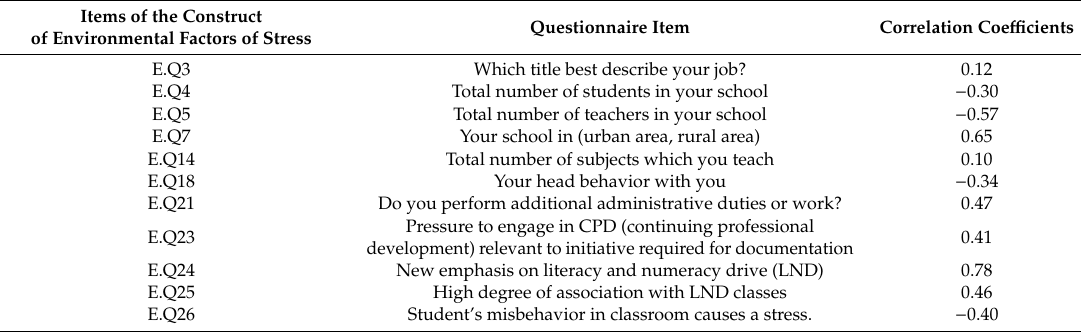
Table 20. Items of the construct of environmental factors of stress.